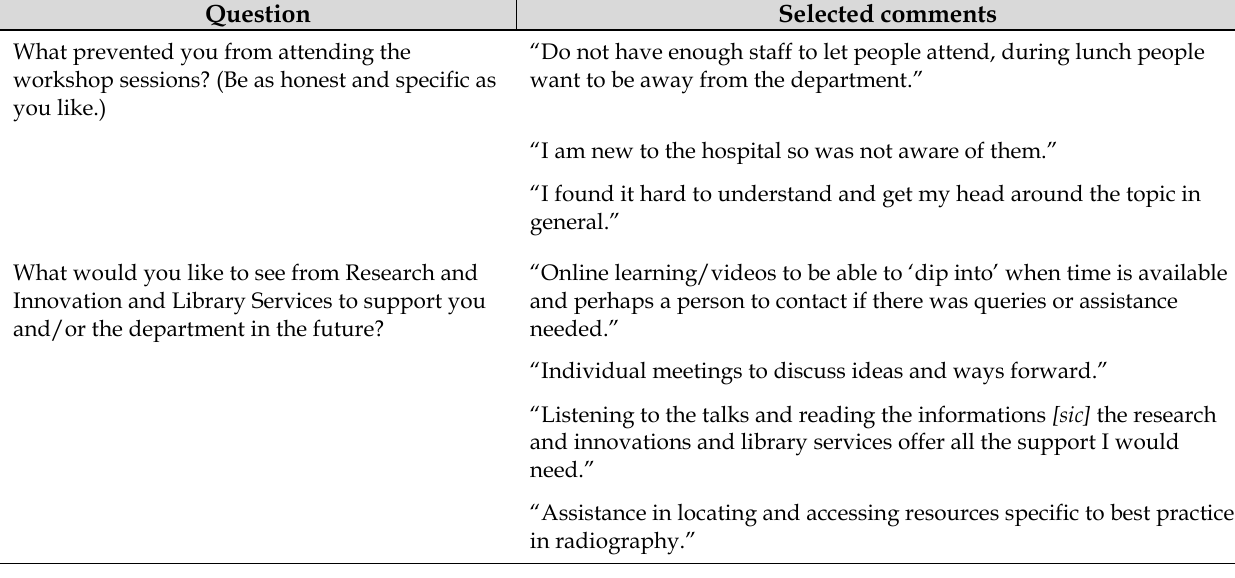
Table 2 Selected responses from non-attender feedback sessions